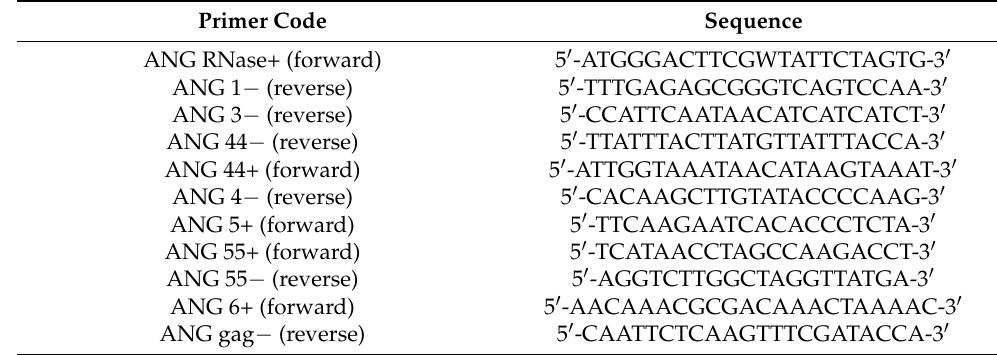
Table 3. List of primers designed on putative LTRs of a group of Copia /Angela full length LTR-REs and used for IRAP